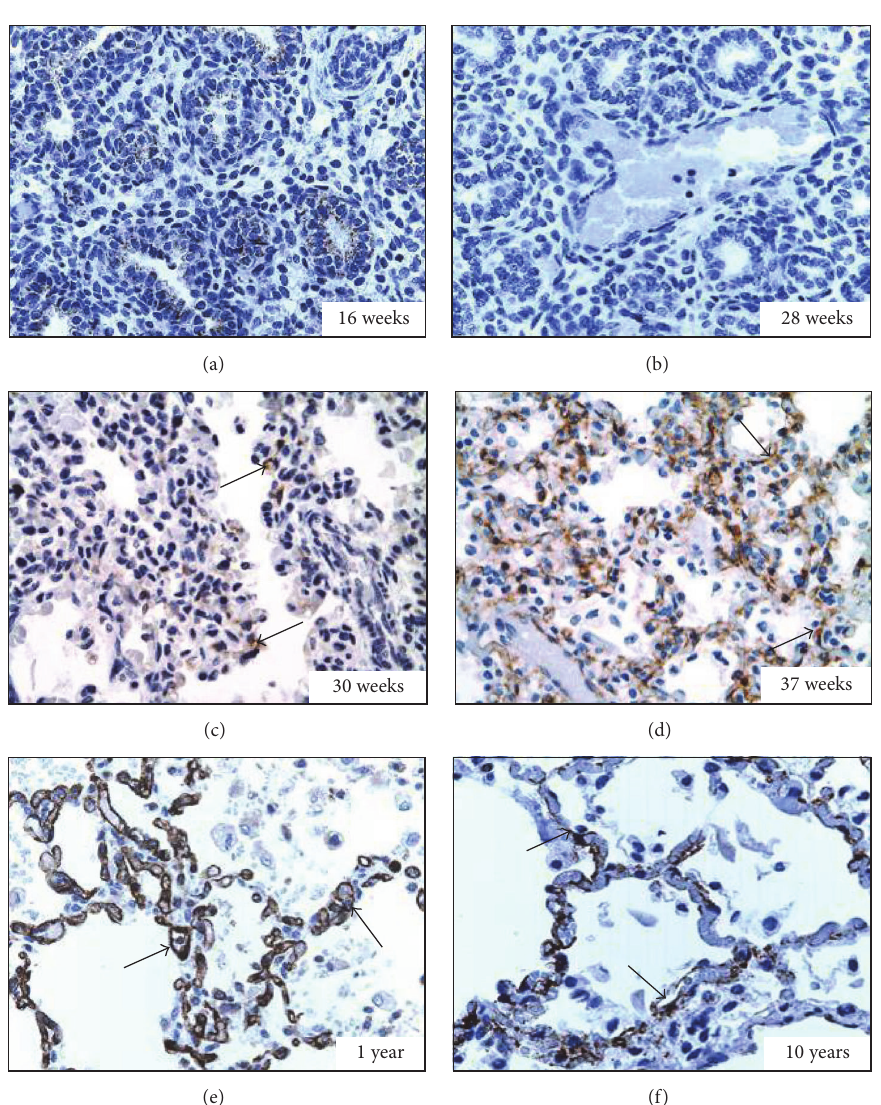
Figure2: ExpressionofSERTinthepulmonaryendotheliumduringdevelopment (3,3 󸀠 -diaminobenzidine,SERTantibodyexpressioninbrown) . (a) At 16 WGA (pseudoglandular stage); no SERT expression is detected (400x). (b) At 28 WGA (canalicular stage) no SERT expression is detected (400x). (c) At 30 WGA (saccular stage) patchy capillary SERT staining (arrows) is detected (400x). (d) At 37 WGA (alveolar stage) diffuse and intense microvascular staining of SERT (arrows) is evident (400x). (e) At one year of age SERT staining (arrows) is diffuse and intense (400x). (f) At 10 years of age SERT staining (arrows) remains diffusely present